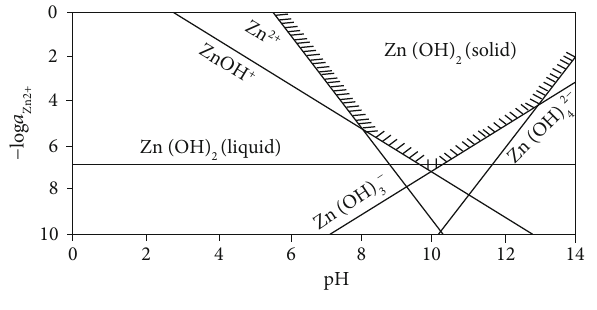
Figure 1: pH – log a